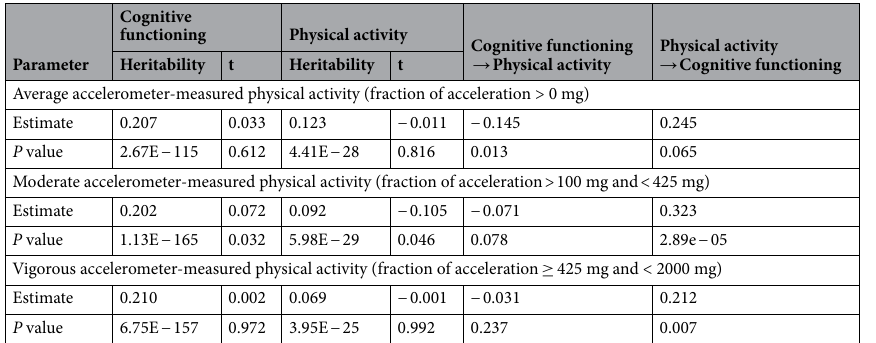
Table 1. Latent Heritable Confounder Mendelian Randomization (LHC-MR) results for the association between accelerometer-measured physical activity and general cognitive functioning. Notes. Parameters estimates and their P -values were obtained from the LHC-MR optimized model with the maximum likelihood. Bidirectional associations from cognitive functioning to physical activity and from physical activity to cognitive functioning are reported. t = effect of the confounder. Bonferroni corrected α = 0.008.